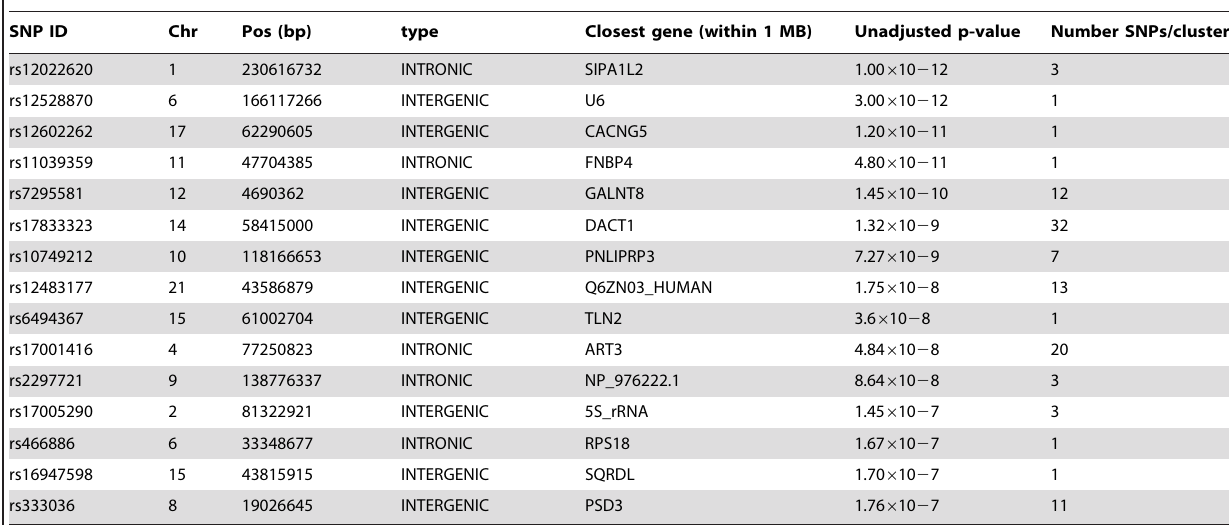
Table 3. Results from GWAS for the HapMap cohort.